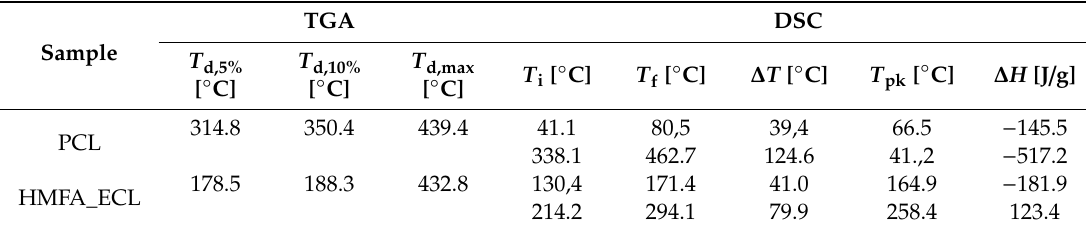
Table 3. Thermal properties of the HMFA_ECL copolymer, compared to the PCL homopolymer.